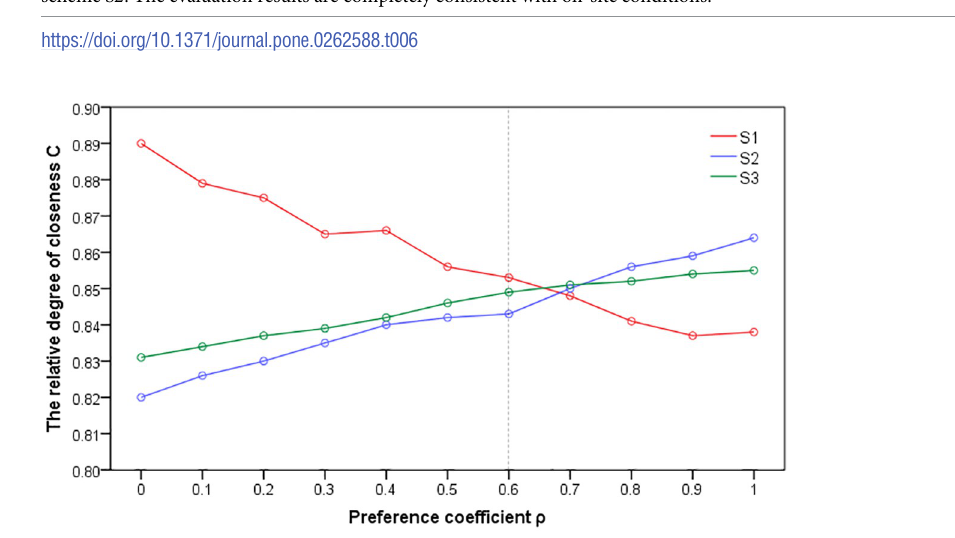
Table 6. Evaluation results of the relative degree of closeness. PROG S1 Relative degree of closeness The degrees of closeness are in the order C S1 > C S3 > C S2 , so scheme S1 is the best, followed by scheme S3 and scheme S2 . The evaluation results are completely consistent with on-site conditions.